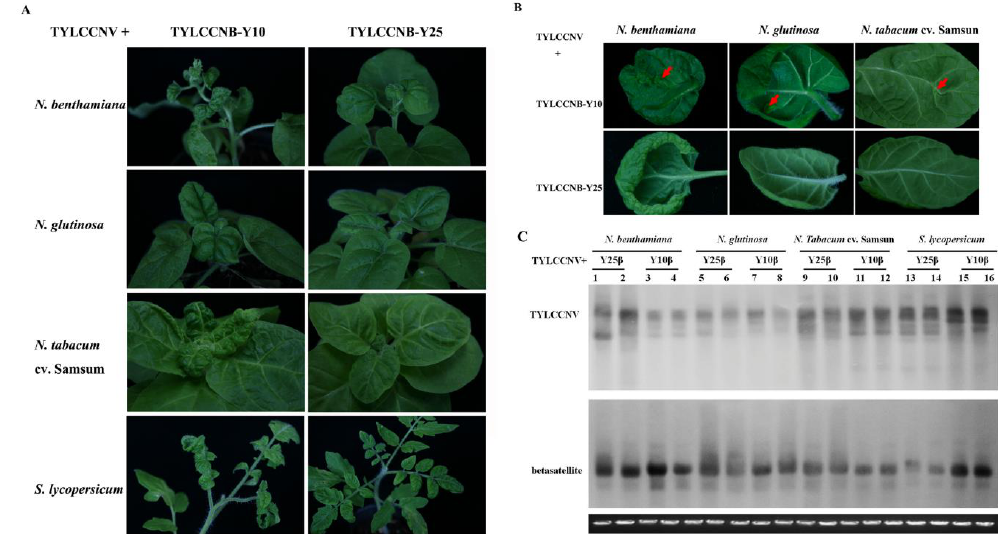
Figure 1. Symptoms induced by co-inoculation with tomato yellow leaf curl China virus (TYLCCNV) with TYLCCNB-Y10 or TYLCCNB-Y25 satellites in N. benthamiana , N. glutinosa , N. tabacum cv. Samsun and S. lycopersicum . ( A ) Whole plants. Photographs of plants were taken at 30 days post inoculation (dpi); ( B ) abaxial surfaces of leaves. Arrowheads indicate enations; ( C ) Southern blot analysis for viral DNA in N. benthamiana , N. glutinosa , N. tabacum cv. Samsun, and S. lycopersicum plants agroinoculated with TYLCCNV along with TYLCCNB-Y10 or TYLCCNB-Y25. The blots were probed either for TYLCCNV (top) or for betasatellite (bottom). The lower panel represents an ethidium bromide-stained gel of DNA samples as a loading control. Y10β, TYLCCNB-Y10; Y25β, TYLCCNB-Y25.